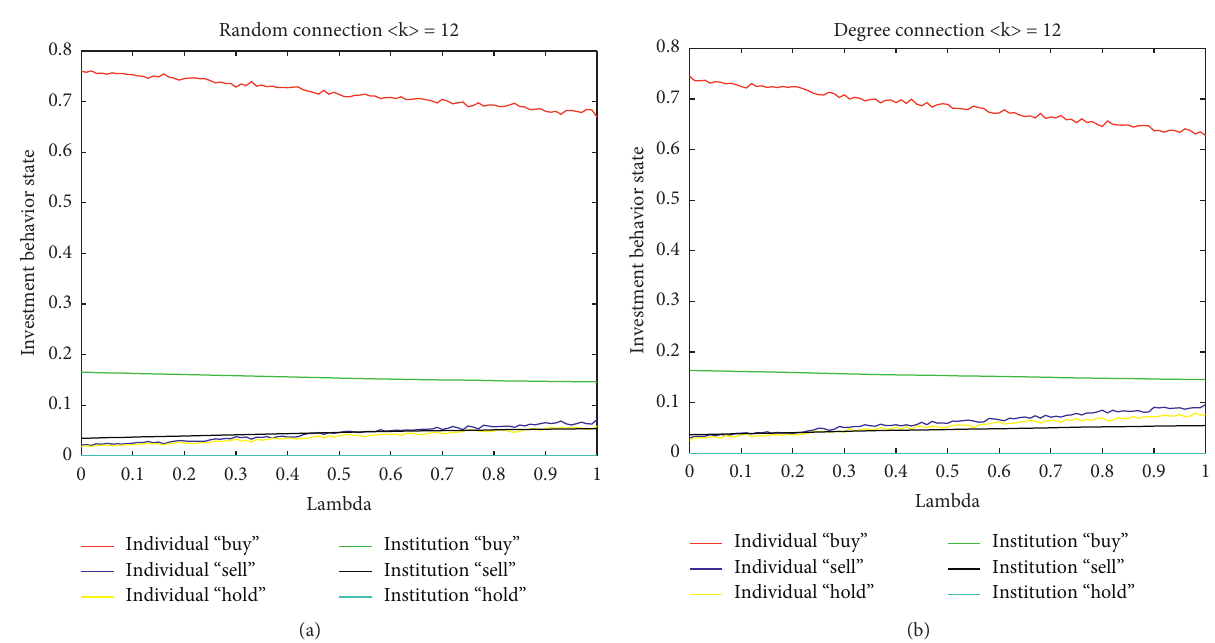
Figure 4: The impact of λ on the evolution of investor